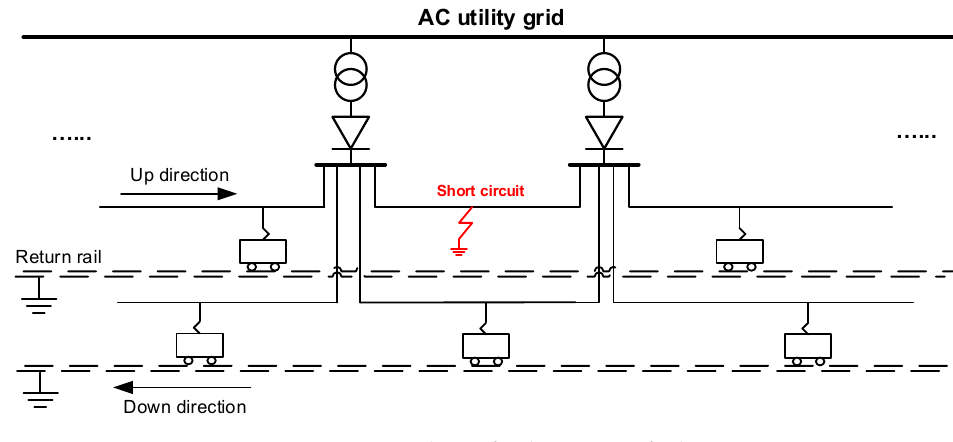
Table 3. Train characteristics.